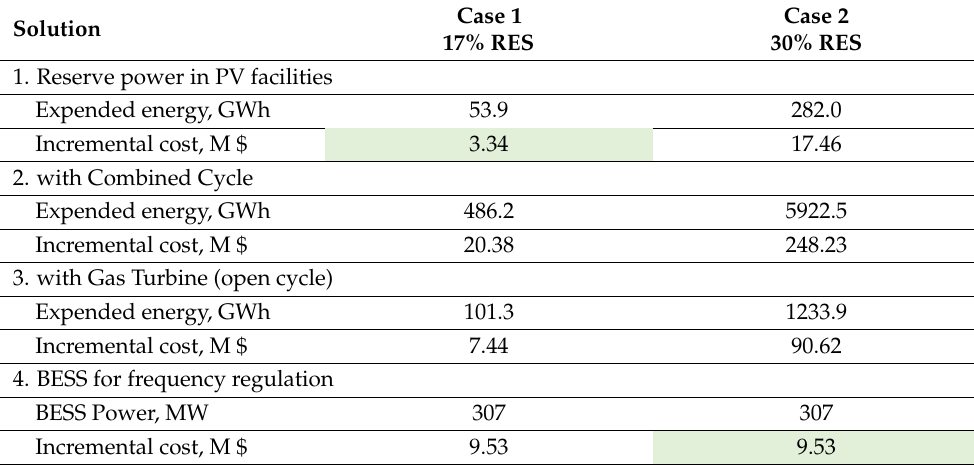
Table 5. Incremental Cost of Sufficient Frequency Response for year